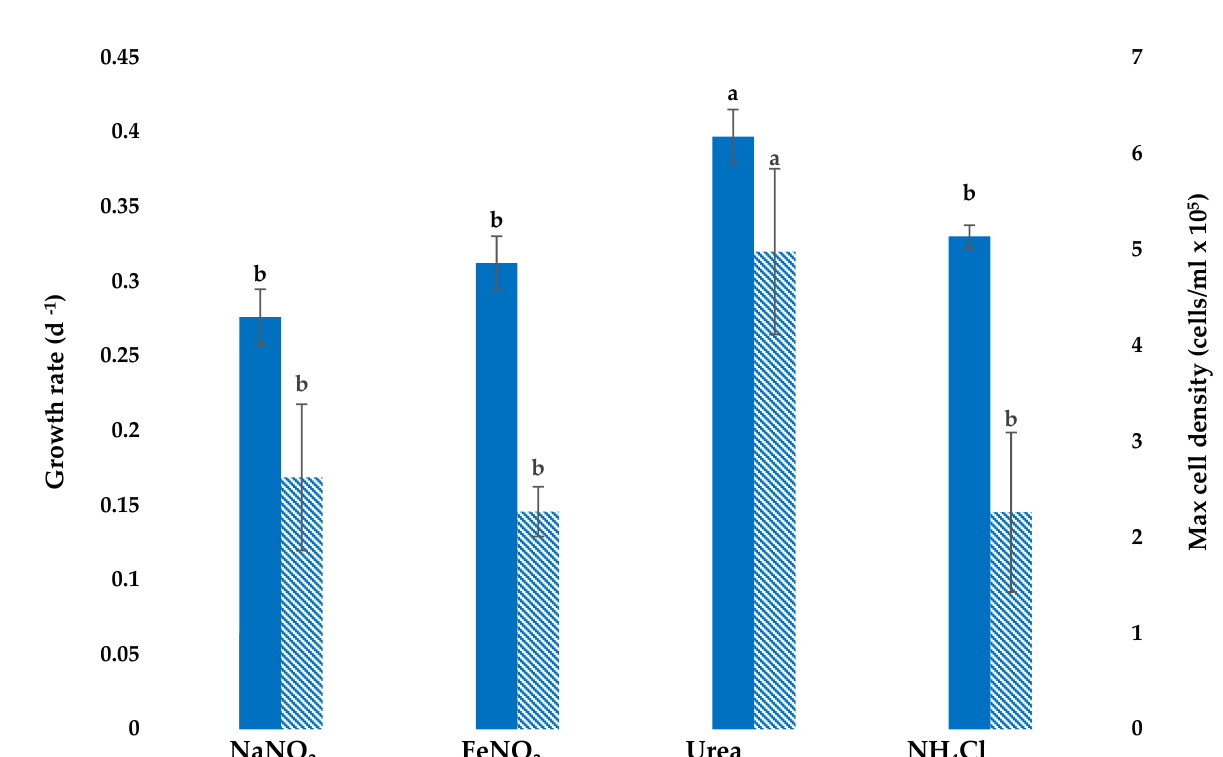
Figure 1. H. pluvialis CCAP 34/1D maximum growth rate and cell density in different NS. Error bars are standard deviations of the means, n = 3. The letters indicate a significant difference in growth media treatments for each measured response (i.e., growth rate or maximum cell density) ( p < 0.05).